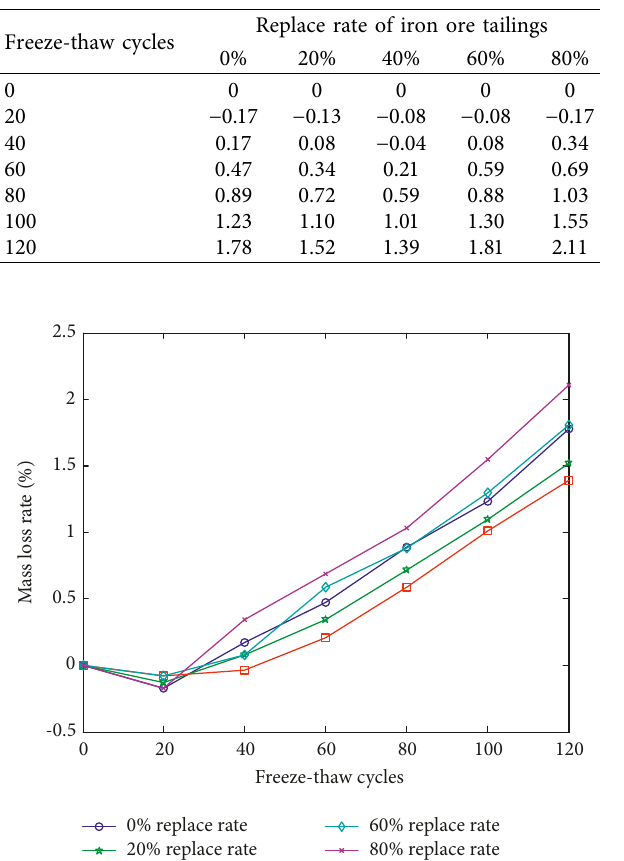
Table 5: Mass loss rate of C30 iron ore tailings concrete after freeze-thaw (%).